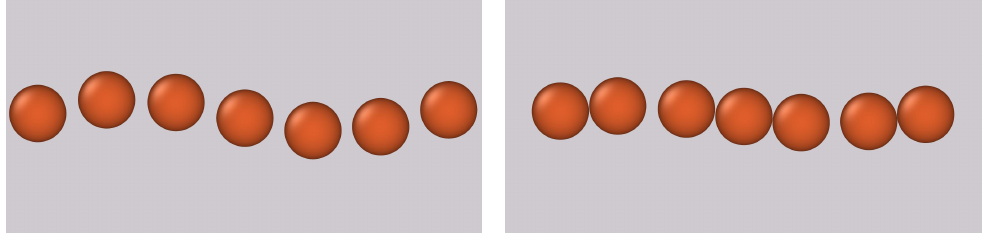
Figure 7. Snapshots of the dynamical simulation model presented in Appendix B. We consider an incompressible matrix with elastic modulus of E = 40kPa and a magnetization behavior of the particles following Equations (1) and (13a). Left side: Initial configuration in the form of a regular helical chain before applying an external magnetic field. Right side: The final configuration when applying a field of B ∞ = 1T along the main chain axis. The full video can be found in the Supplementary Materials (Video2.avi). The snapshots and videos have been visualized using OVITO [89].